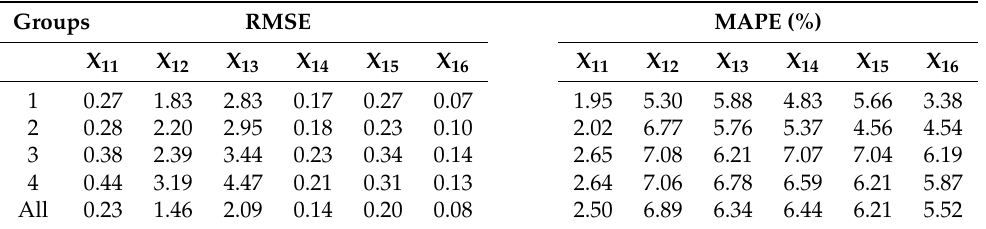
Table 5. The measurement accuracy of scale-invariant traits for plants with different occlusions. Groups